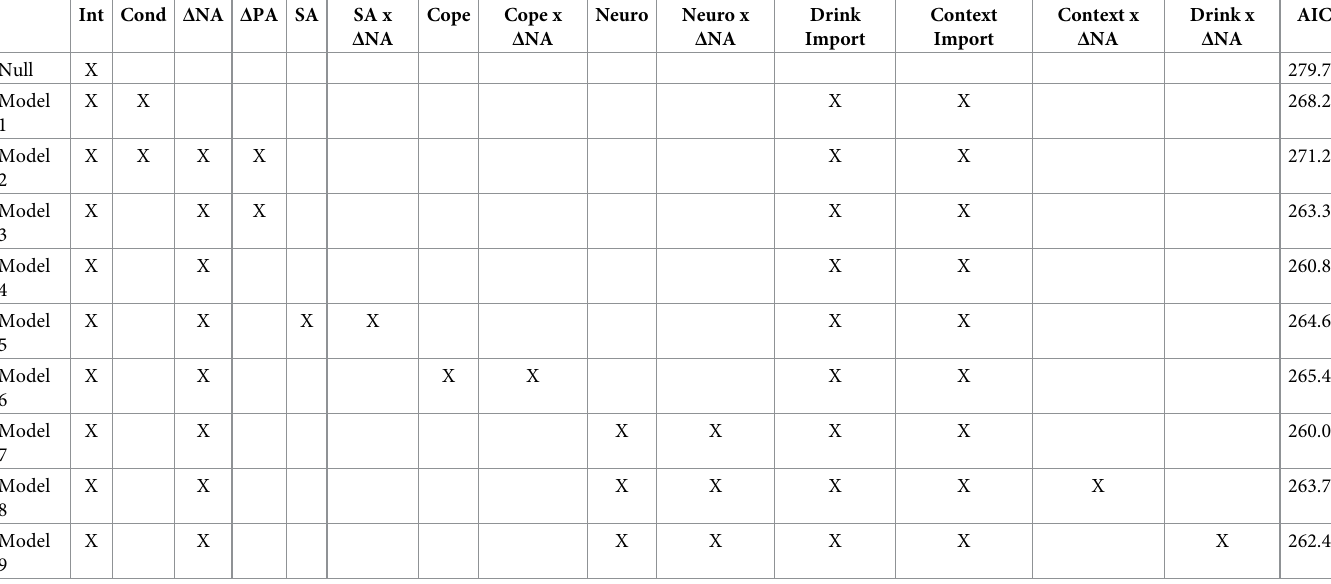
to as the neuroticism model) was retained as the best fitting model. This model was then com- pared to one that also included a context importance by NA change interaction term, as well as a model that included a drink importance by NA change interaction (models 8 and 9). The Table 5. Model variables and original